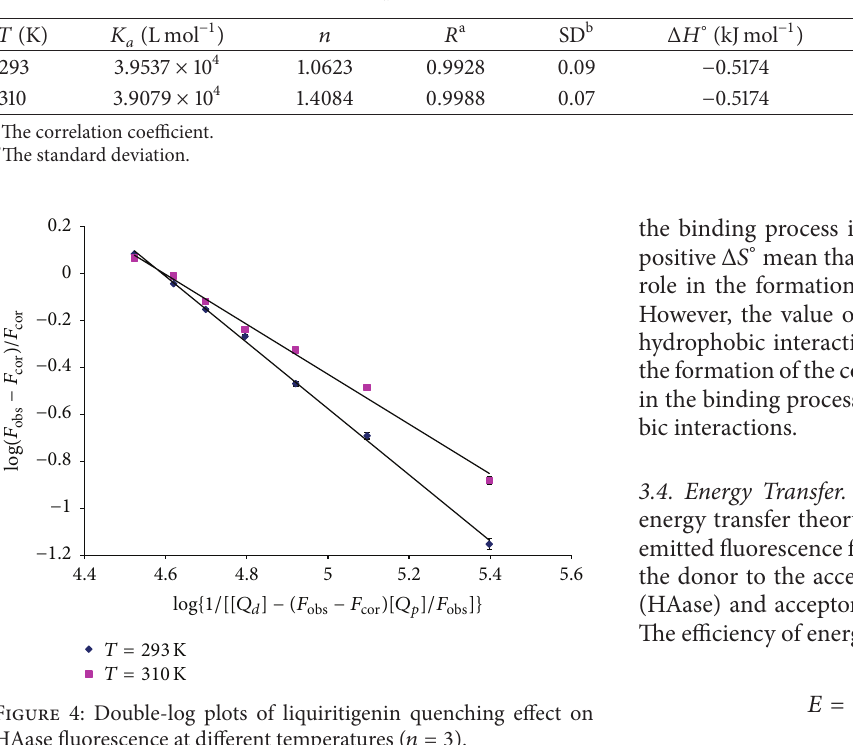
Table 1: Stern-Volmer constants for the interaction of HAase with liquiritigenin at different temperatures ( 𝑛 = 3 ). 𝑇 (K) Equations 𝐾 𝐹 /𝐹 = 4.4157[𝑄] + 0.8483 4.4157 × 10 4 obs cor /𝐹 = 3.9668[𝑄] + 0.9838 3.9668 × 10 4 3.9668 × 10 12 0.11 𝐹 obs cor a The correlation coefficient. b The standard deviation. Table 2: The binding constant 𝐾 𝑎 and relative thermodynamic parameters of the liquiritigenin-HAase system ( 𝑛 = 3 ).